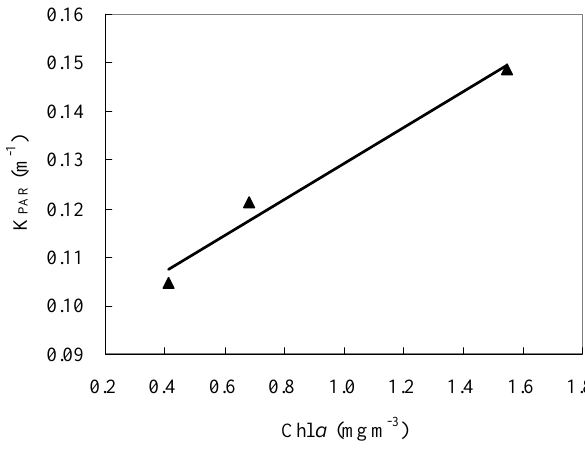
Fig. 7. A relationship between chl- a concentration versus vertical light attenuation coefficient ( K PAR )